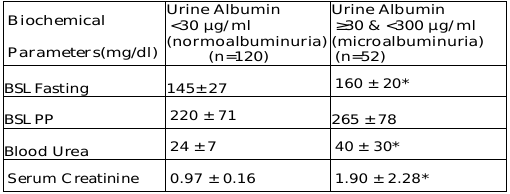
Data are Mean ± SD Significantly different from